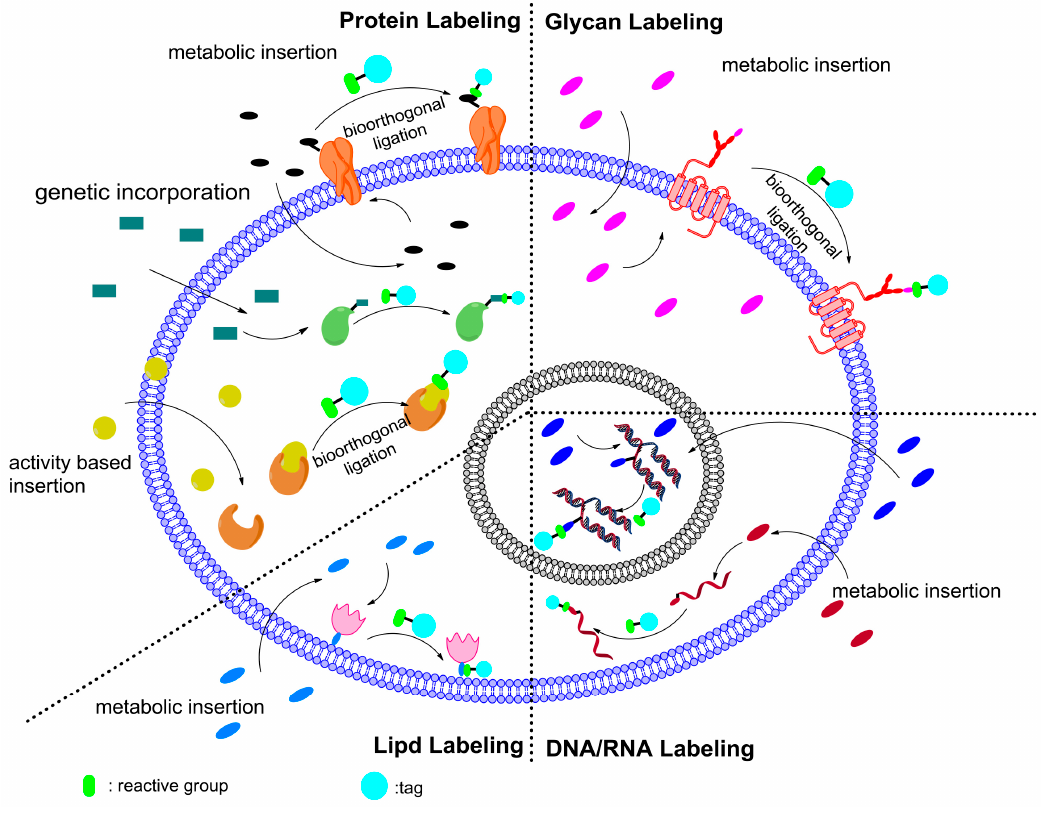
Figure 2. Bioorthogonal labeling of biomolecules with CuAAC.